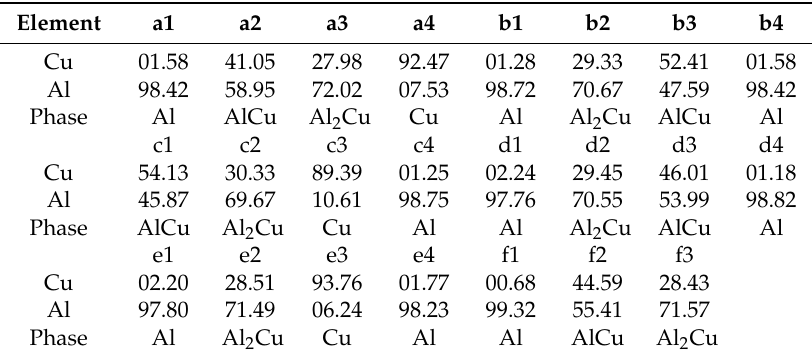
Figure 9. Peeled surface morphology (BSE image) of the Cu/Al clad sheets after multi-pass rolling with thicknesses of 7 mm ( a , b ), 5 mm ( c , d ) and 3 mm ( e , f ). ( a , c , e : Cu side; b , d , f : Al side). Table 6. The EDS results for the peeled surfaces in Figure 9